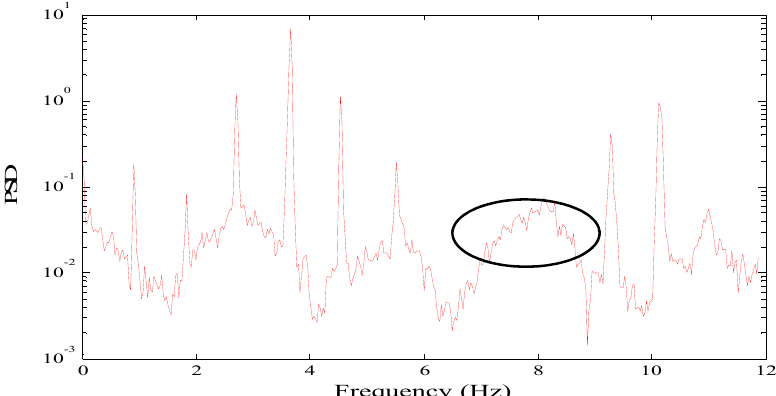
Figure 2. Power spectral density with frequency missing.